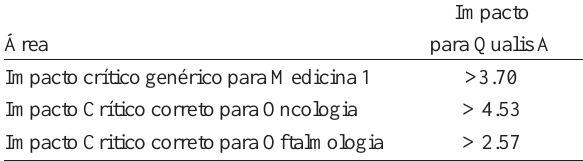
Tabela 1. Fator de impacto limite para 25% das revistas das áreas.